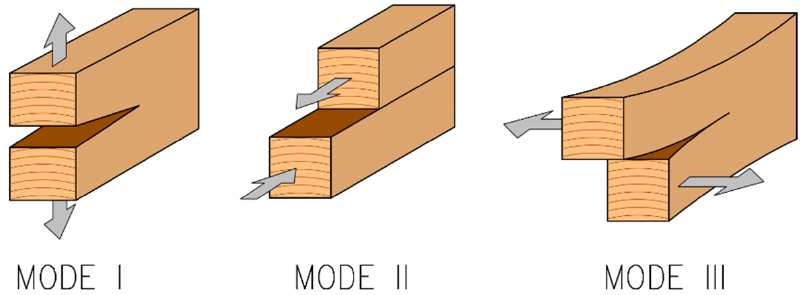
Figure 4. Failure modes according to linear elastic fracture mechanics.